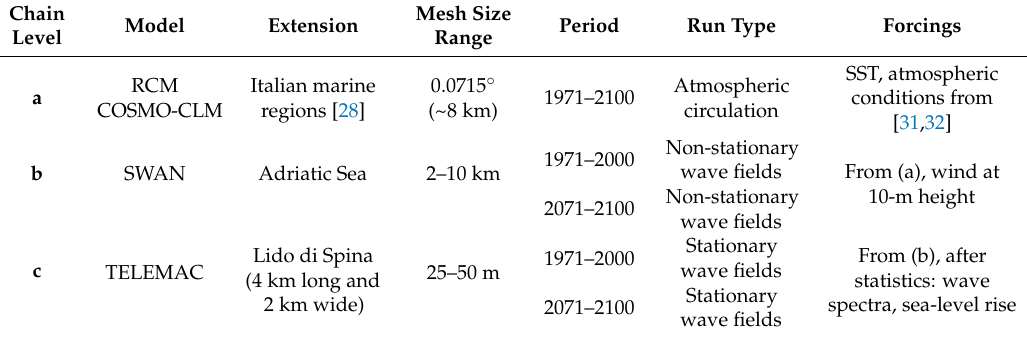
Table 1. Numerical characteristics of the proposed nesting approach for each of the different chain levels, i.e., the model extension, the mesh size range, the simulated period, the type of run, and the forcings inducing atmospheric and sea